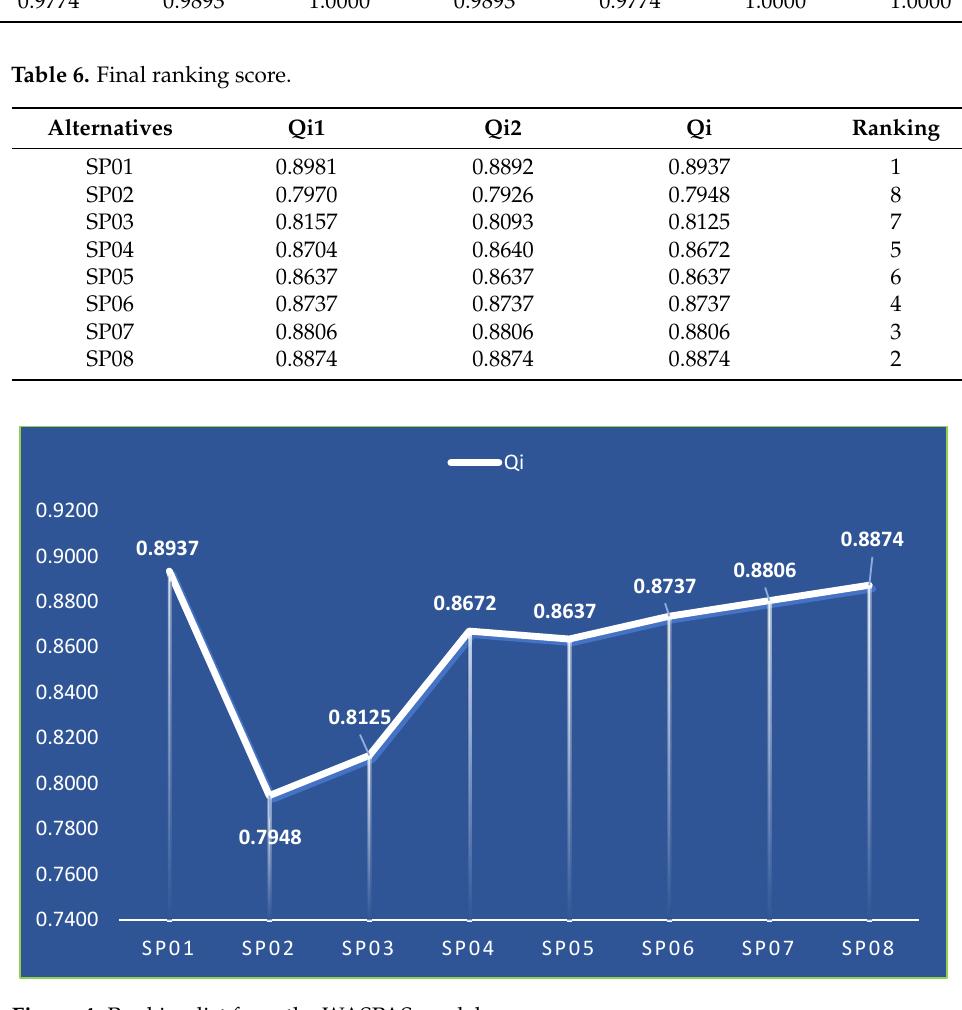
Figure 4. Ranking list from the WASPAS model.